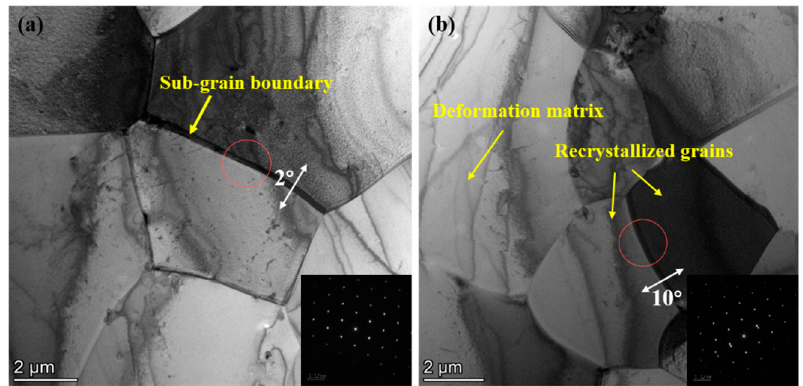
Figure 7. Subgrain boundaries and recrystallization at grain boundaries at 680 °C: ( a ) subgrain boundaries and ( b ) recrystallization at grain boundaries.